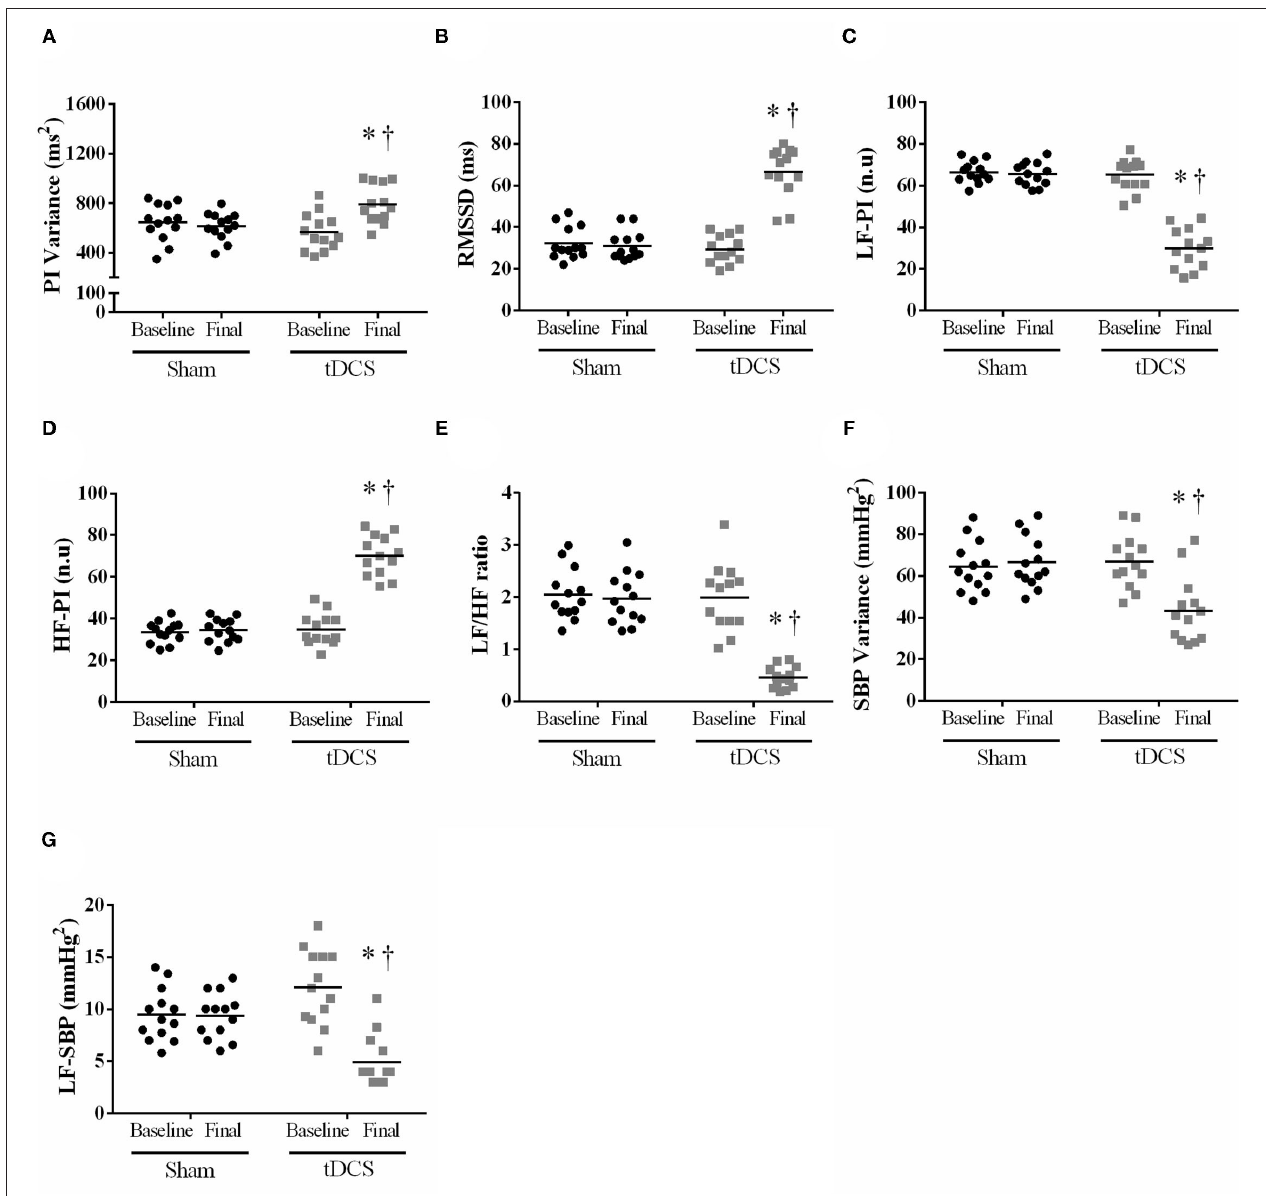
FIGURE 3 | Short-term intervention (10 sessions): tDCS or SHAM effects on pulse interval and systolic blood pressure variability. Repeated measures ANOVA with Bonferroni post-test. (A) PI Variance - pulse interval variance [ P = 0.0006 vs. SHAM; Interaction – P = 0.0002]; (B) RMSSD - square root of the mean of the square of the differences between adjacent standard RR intervals [ P = 0.0421 vs. SHAM; Interaction – P = 0.0033]; (C) LF-PI - low-frequency band of the pulse interval expressed in n.u. [ P = 0.0002 vs. SHAM; Interaction – P = 0.0003]; (D) HF-PI - a high-frequency band of the pulse interval expressed in n.u. [ P < 0.0001 vs. SHAM;